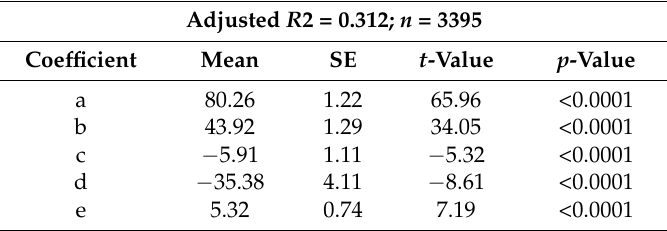
Table 7. Regression analysis for chain flail delimber–debarker–chipper (CFDDC) productivity (m 3 PMH − 1